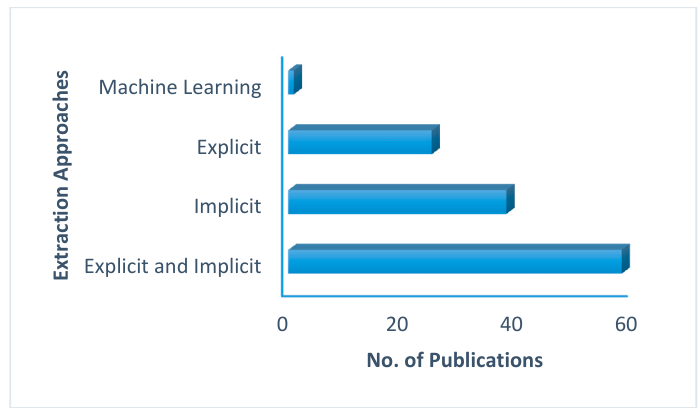
Figure 4. Classification by extraction method.